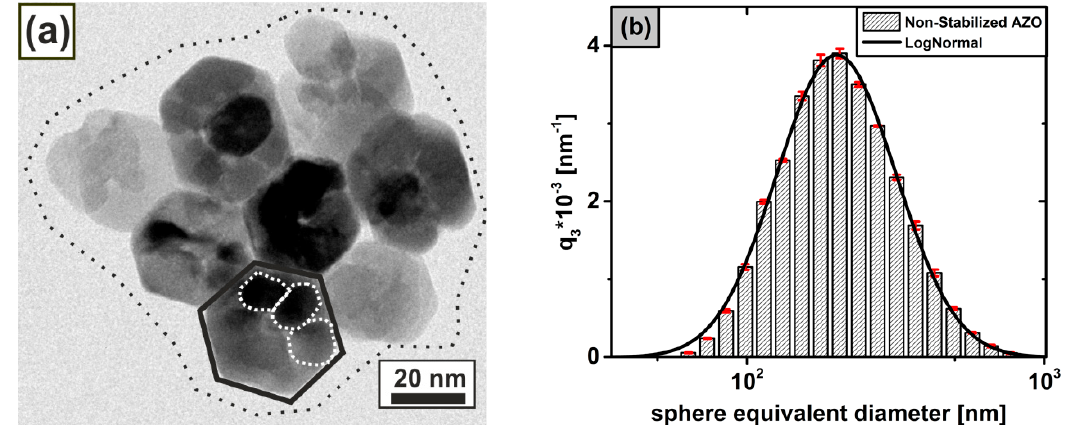
Figure 2. ( a ) HRTEM image of an aggregate (dotted line) based on hexagonal-shaped AZO mesocrystals (solid line) with internal grain boundaries (dashed line); and ( b ) volume-weighted size density distribution of the non-stabilized AZO dispersion in ethanol from DLS data (bars) including the associated log-normal distribution (solid